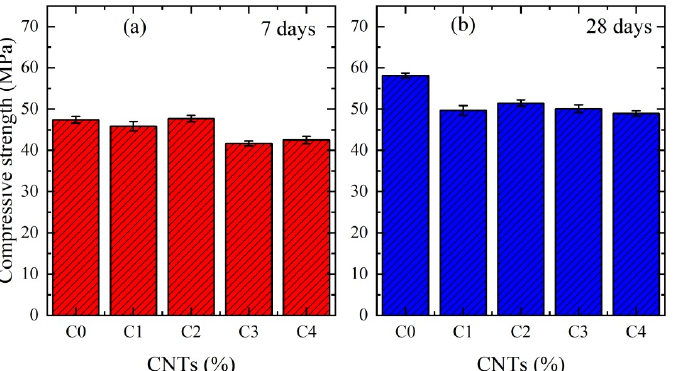
Figure 3. Compressive strength of cement mortars with different wt.% of MWCNTs. The results are for 15 min of sonication time without surfactant. ( a ) for 7 days, ( b ) for 28 days.